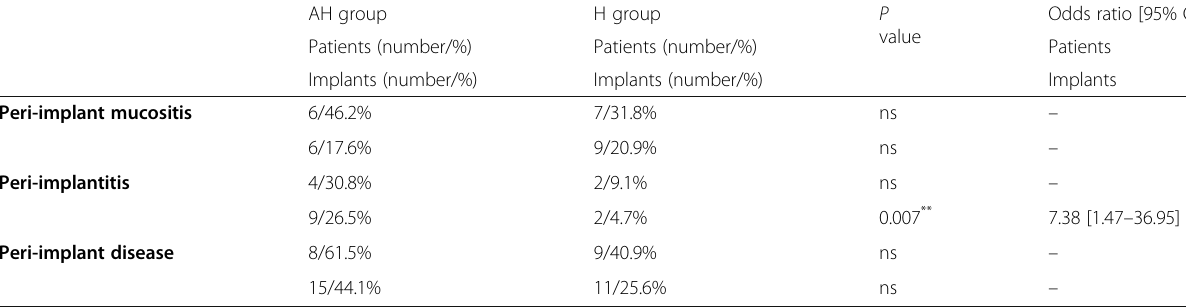
Table 4 Proportion of patients and implants diagnosed with peri-implant disease